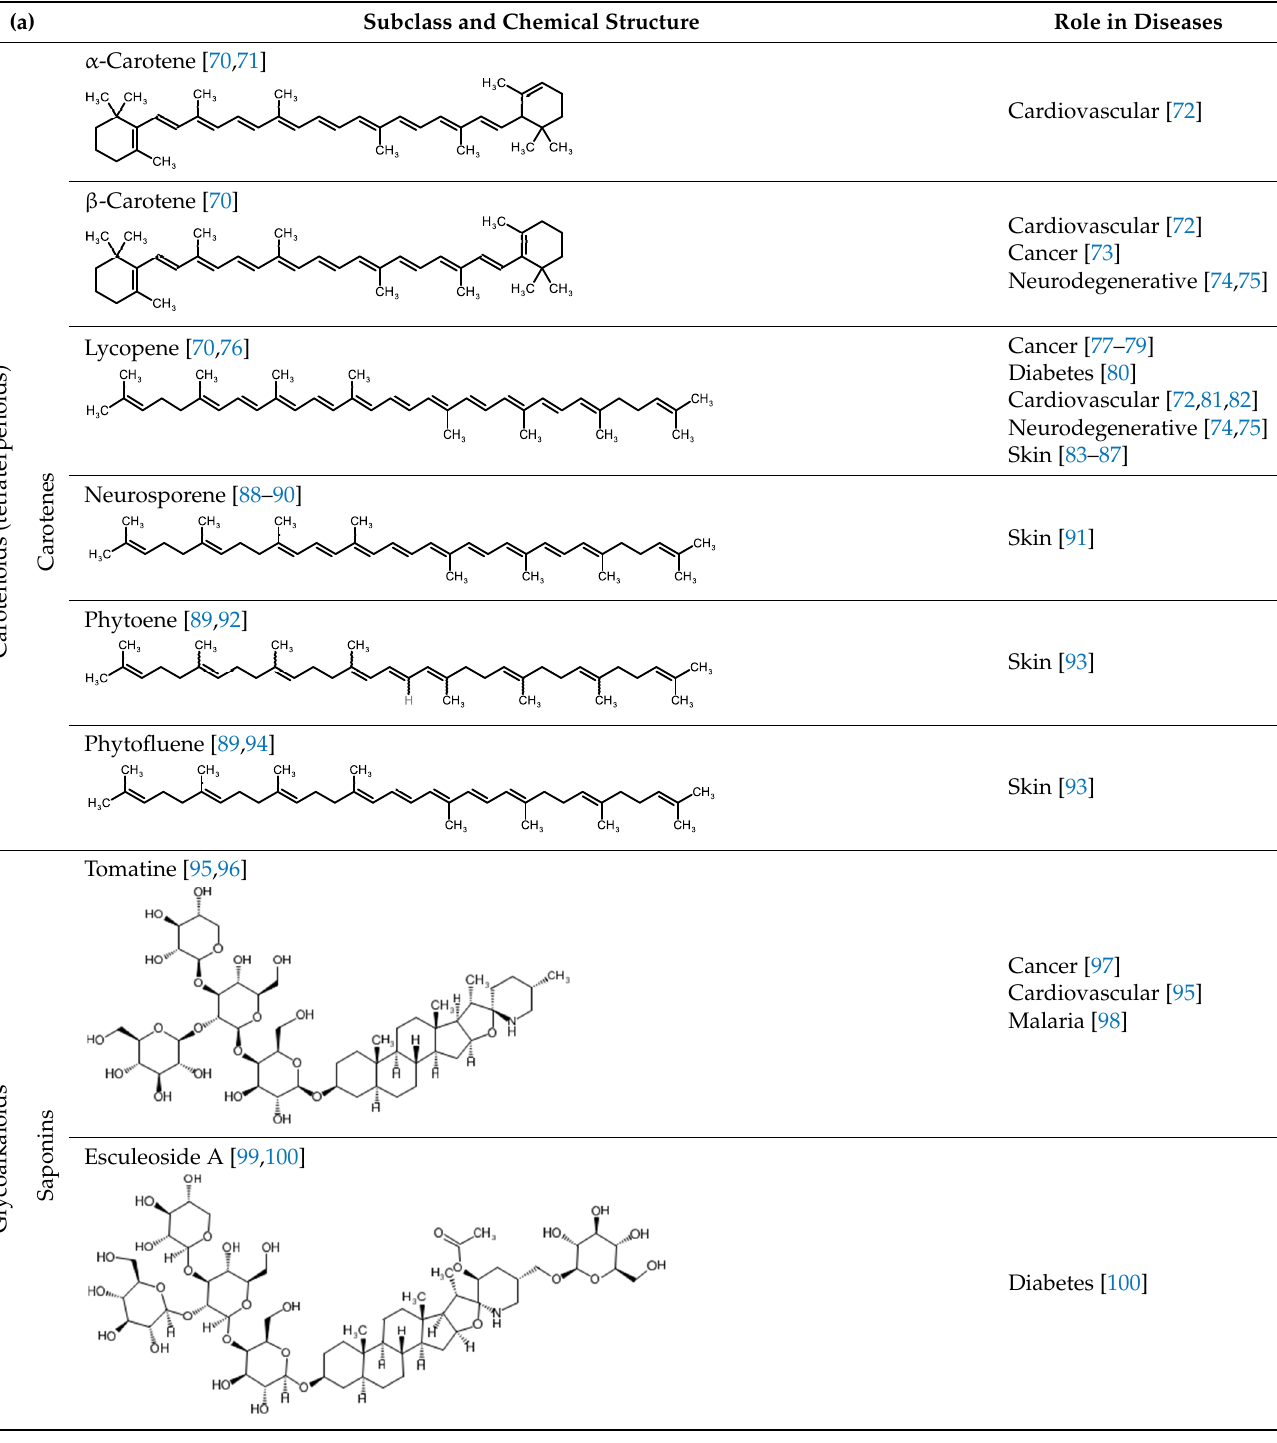
Table 1. ( a ) Carotenoids and glycoalkaloids found in tomato ripe fruits. ( b ) Vitamins and polyphenols found in tomato ripe fruits.